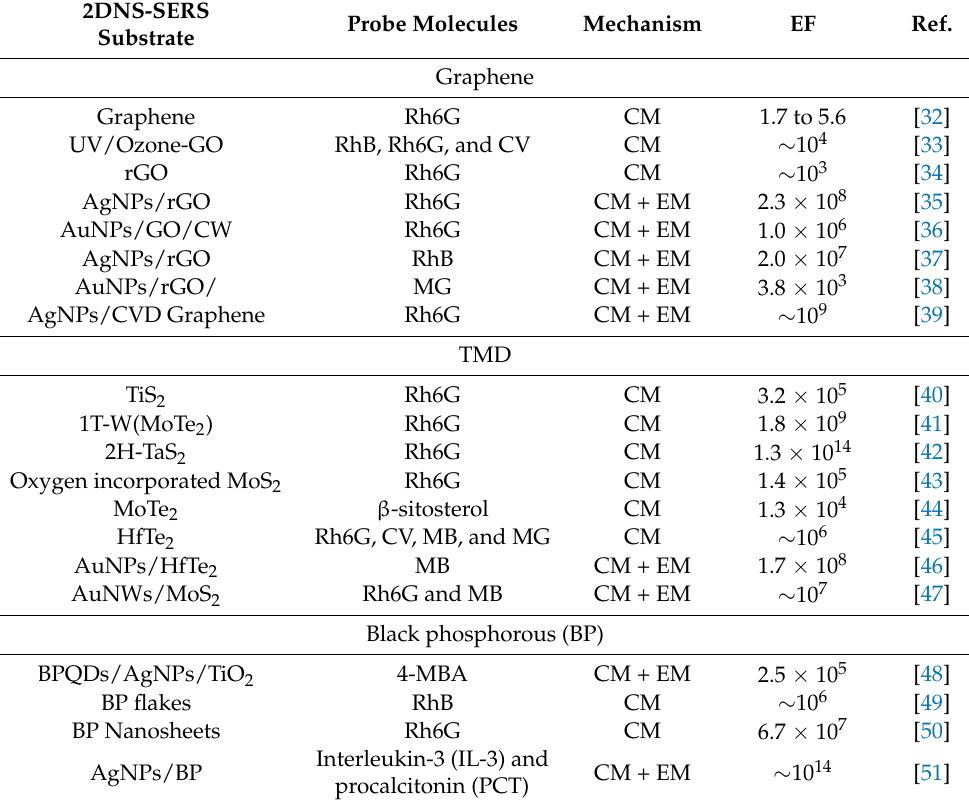
Table 1. Representative examples of 2DNS-SERS substrates (Rhodamine 6G (Rh6G); Rhodamine B (RhB); Malachite Green (MG); Methylene Blue (MB); Crystal Violet